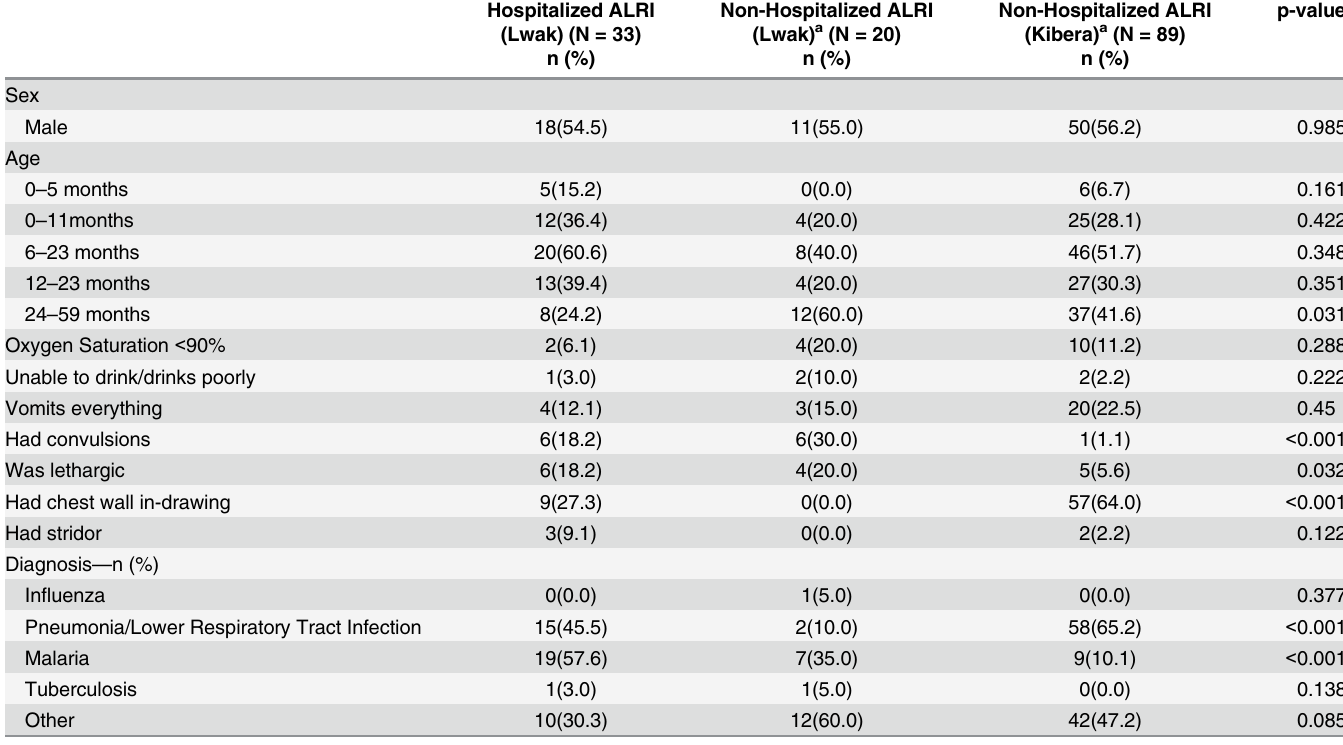
Table 5. Characteristics of Hospitalized (Lwak only) and Medically attended Non-Hospitalized Acute Lower Respiratory Tract Illness (ALRI) a (Lwak and Kibera) Attributable to Laboratory-Confirmed Influenza, 2008 –